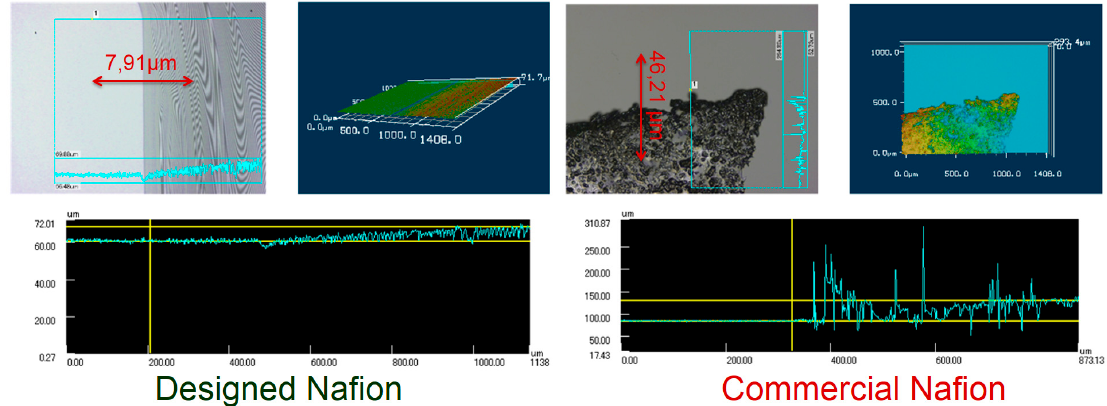
Figure 10. Width of Nafion membranes computed by laser confocal microscopy. In the left part, the Nafion membrane designed from Nafion solution. In the right part is a 40 µm width dry commercial Nafion membrane. The homogeneity of the left part is quite better than the right part. The commercial Nafion is also less transparent than the other one. For designed Nafion and commercial Nafion, the 3 subfigures represents the width and the surface the membrane. The top left is the computation by laser confocal microscopy (bright part is glass surface, dark part is membrane surface). The top right is the topography of the membrane showing the heterogeneity of the membrane. The bottom subfigure represents the width computation of the membrane in µm.